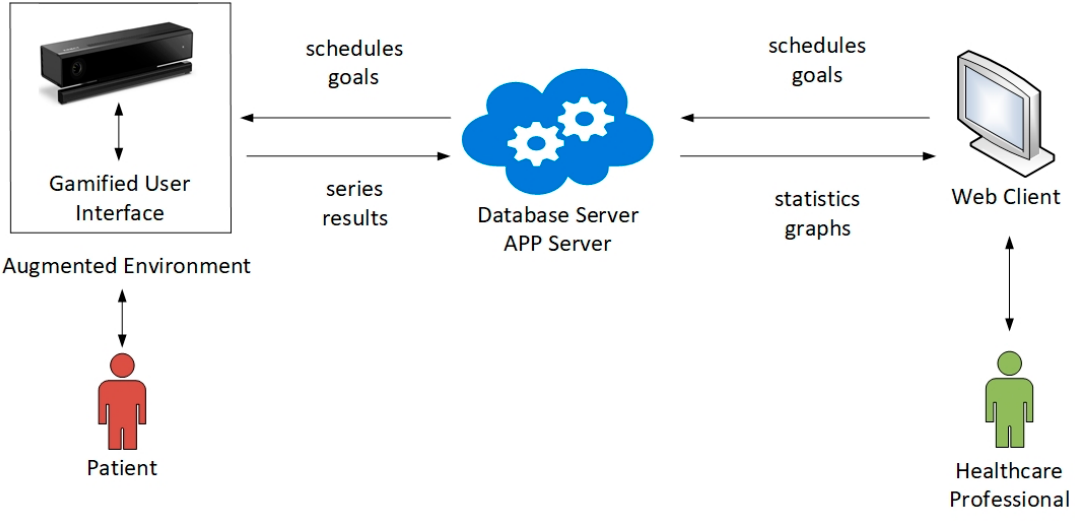
Figure 1. System Architecture of KineActiv.